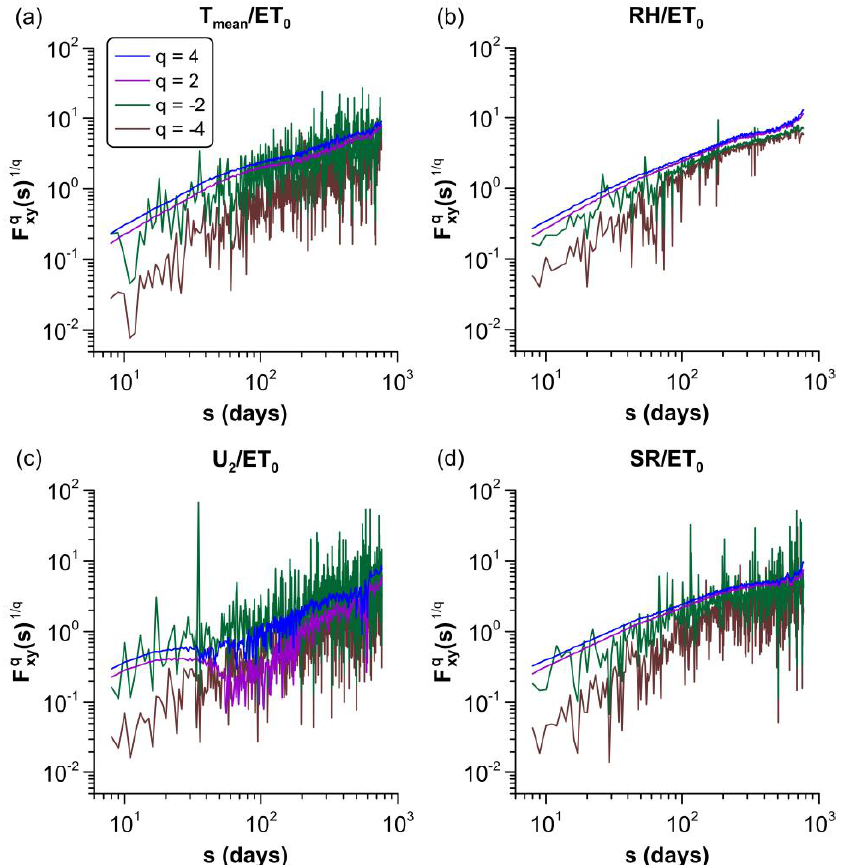
Figure 4. Detrended cross-covariance functions 𝐹 𝑥𝑦𝑞 (𝑠) 1/𝑞 . For reasons of clarity, only fluctuation functions for q = [ − 4, − 2, 2, 4] are displayed. ( a ) 𝑇 𝑚𝑒𝑎𝑛 — 𝐸𝑇 0 . ( b ) 𝑅𝐻 — 𝐸𝑇 0 . ( c ) 𝑈 2 — 𝐸𝑇 0 . ( d ) 𝑆𝑅 — 𝐸𝑇 0 . Log – log plots of the second-order covariance functions, 𝐹 𝑥𝑦2 (𝑠) 1/𝑞 , of each meteoro- logical factor with 𝐸𝑇 0 and second-order variance functions, 𝐹 2 (𝑠) , obtained in the pre- vious section, are shown together vs. the scale in Figure 5. Linear trends (solid lines) of 𝐹 𝑥𝑦2 (𝑠) and 𝐹 2 (𝑠) with scale can be noticed in Figure 5a,b,d, showing the power-law scal- ing of these functions. Correlation coefficients of linear fits for these curves can also be seen in this figure. Once again, the protocol of Makowiec and Fuliński was applied to the detrended cross-correlation functions to consider the scaling exponents as representatives of the scaling phenomenon [50].